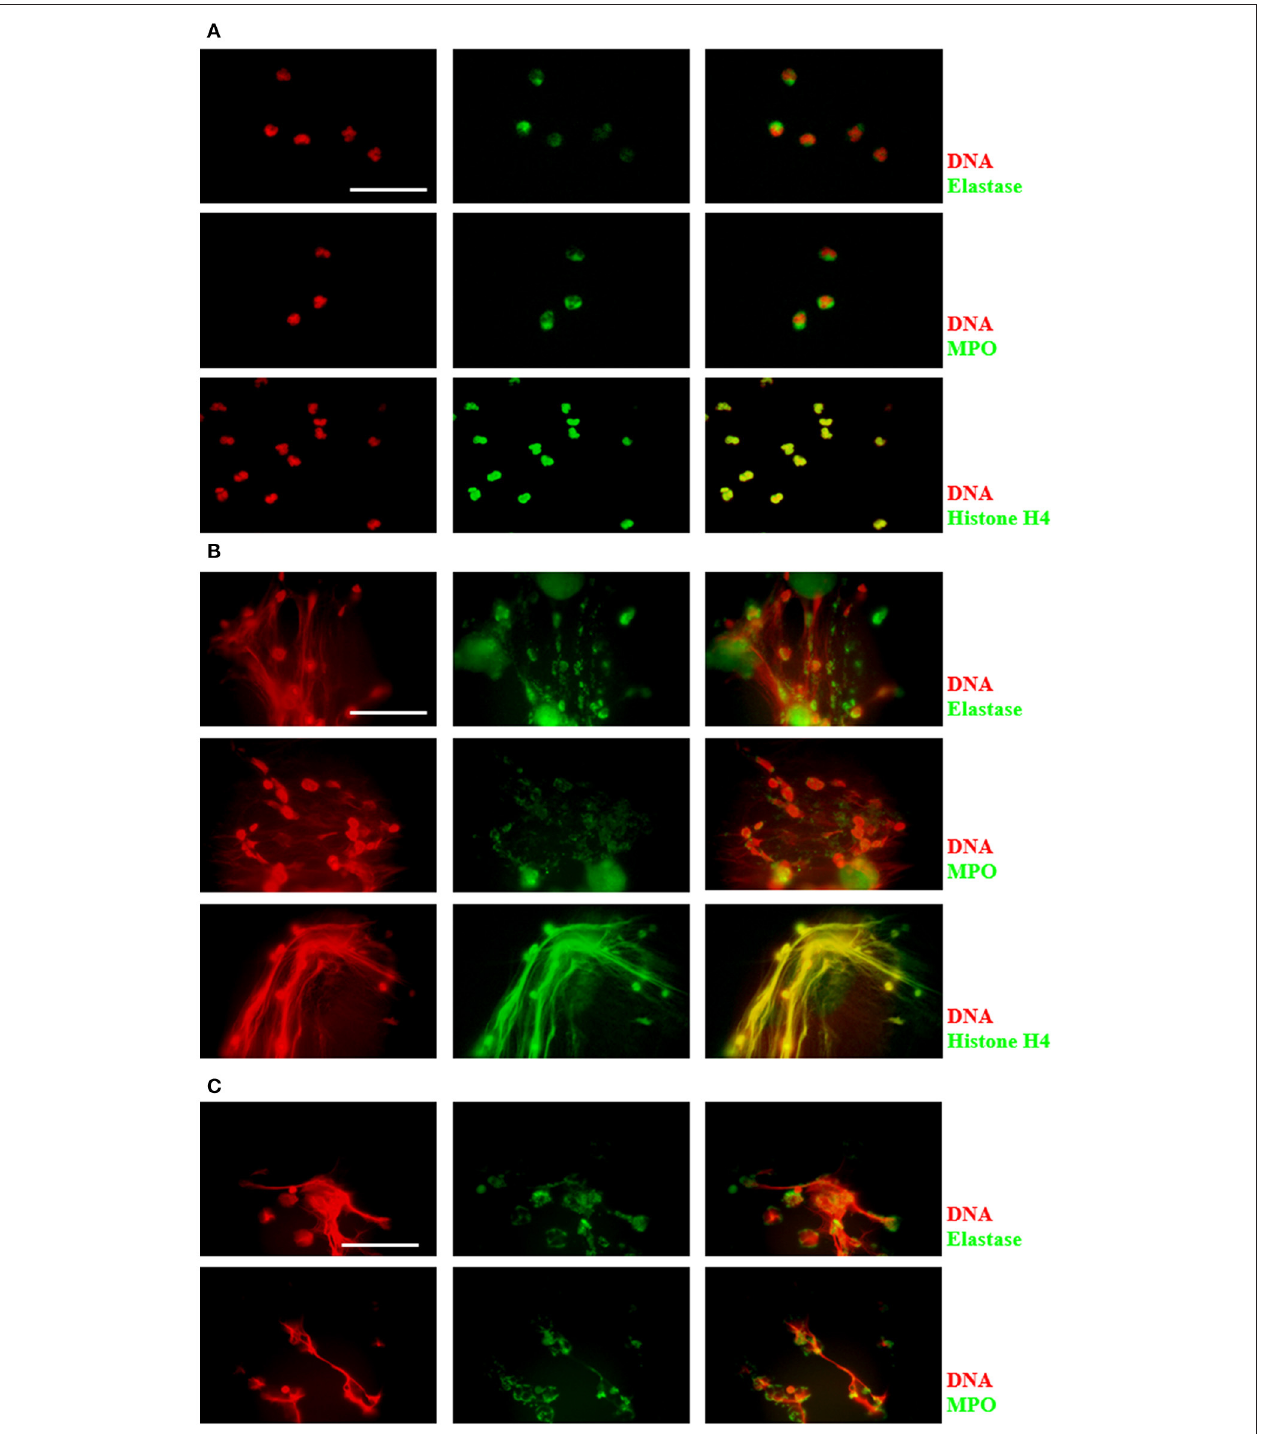
FIGURE 1 | Characterization of components in NETs induced by E. histolytica trophozoites. Human neutrophils (2 × 10 5 ) were cultured in absence of stimuli (A) or stimulated with 1 × 10 4 trophozoites (B) or 20nM PMA (C) in RPMI medium during 4h at 37 ◦ C. Cells were fixed and immunofluorescence was performed using anti-neutrophil elastase (NE), anti-myeloperoxidase (MPO) or anti-histone H4 antibodies followed by anti-mouse IgG conjugated to FITC (for NE and MPO) or anti-rabbit IgG conjugated to TRITC (for histone H4). DNA was stained with DAPI. Images were taken at 100x magnification. Scale bar 50 µ m.